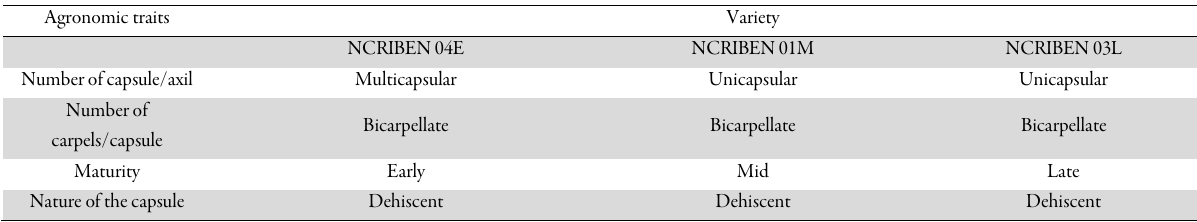
Table 1. The basic agronomic traits of the three varieties used Agronomic